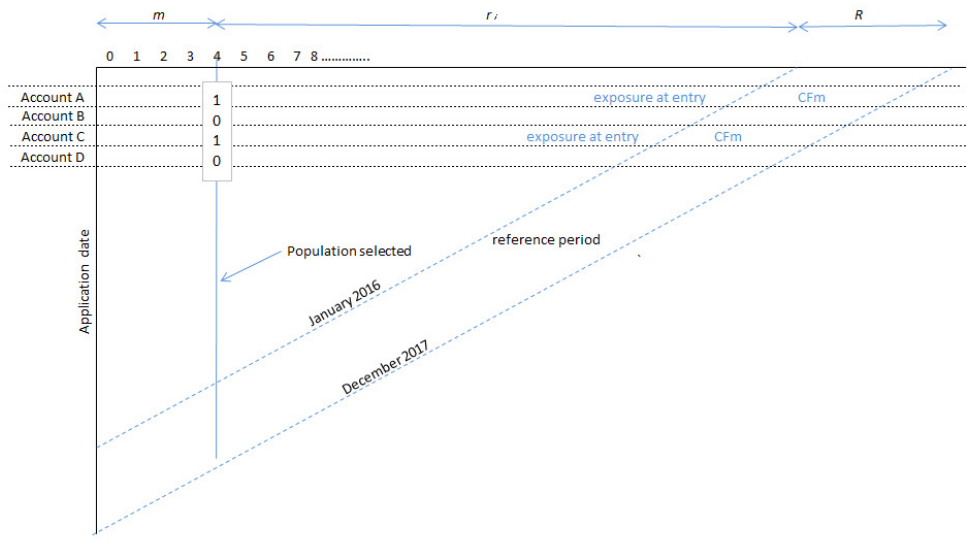
Figure 1. Definition of the reference period for IFRS 9 using an